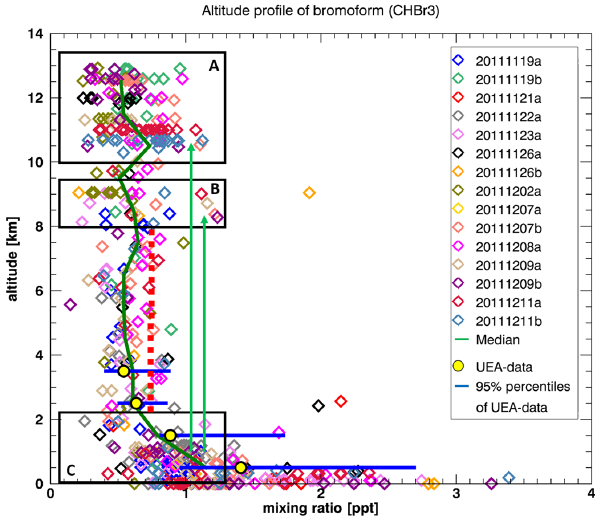
Figure 3. Vertical profile of CH 2 Br 2 . The colour coding indicates the different flights and the corresponding numbering is the date of the flight in the format year (YYYY), month (MM), day (DD) and a letter, whether it is the first (a) or the second (b) flight of a day. The green line marks the median of the GHOST-MS data binned in 1km altitude intervals. The yellow filled circles are the median of the WASP data for the same intervals and the blue horizontal bars show the related 95% percentiles. For better visualization, no error bars for the individual points of the GHOST-MS measurements are shown. The measurement uncertainty for the particular substance is listed in Table 2.